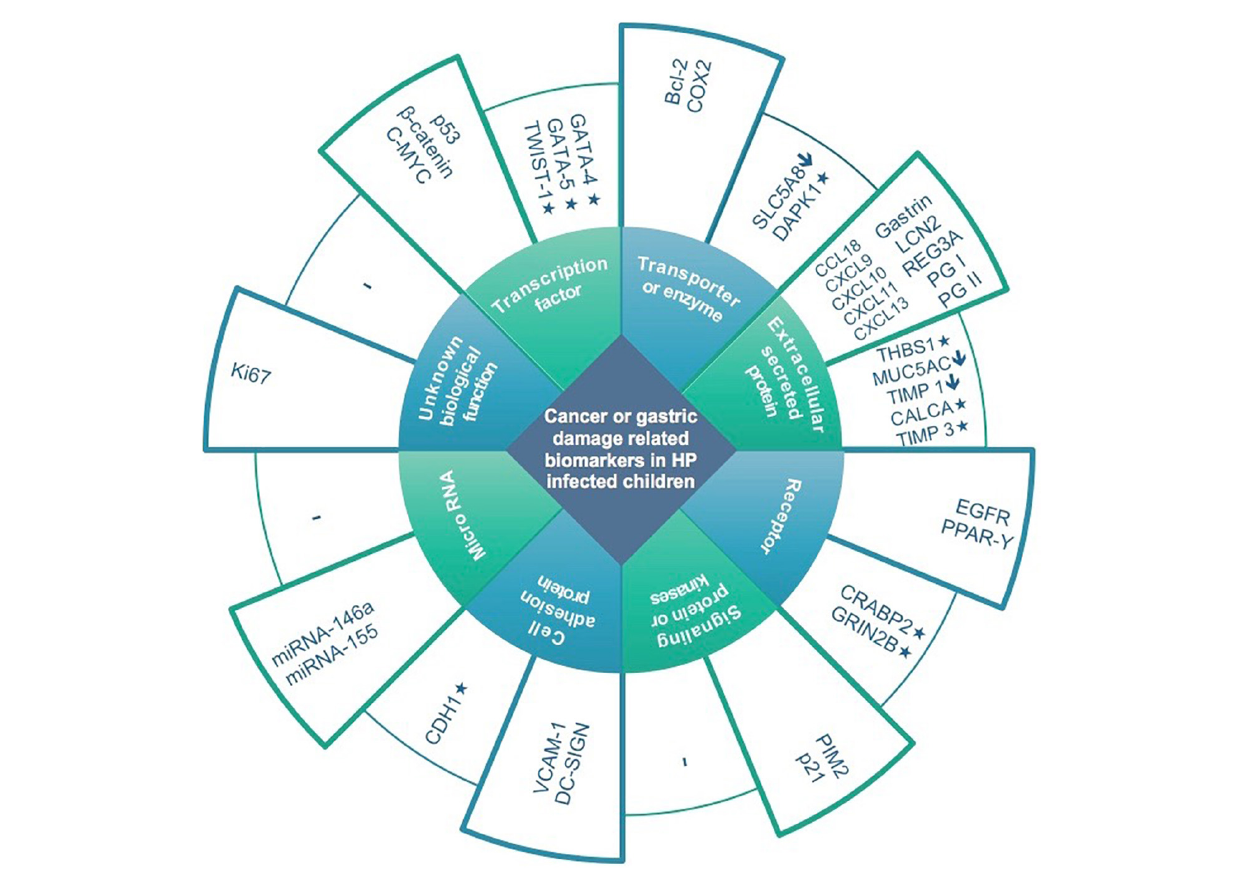
FIGURE 1 | Expression and methylation levels of biomarkers potentially related to gastric damage or oncogenesis in H. pylori infected children, classified according to biological function. Higher columns represent overexpression in infected children compared to non-infected controls. Lower columns represent underexpression ( ↓ ) and/or methylation